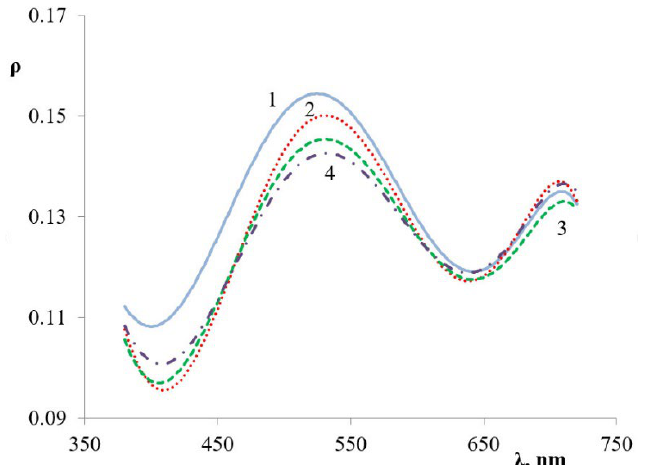
Figure 6. Reflection spectra of core/shell pigment samples with doped PANi coating. The core of the pigment: (1) kaolin, (2) talc, (3) bentonite, (4) muscovite.